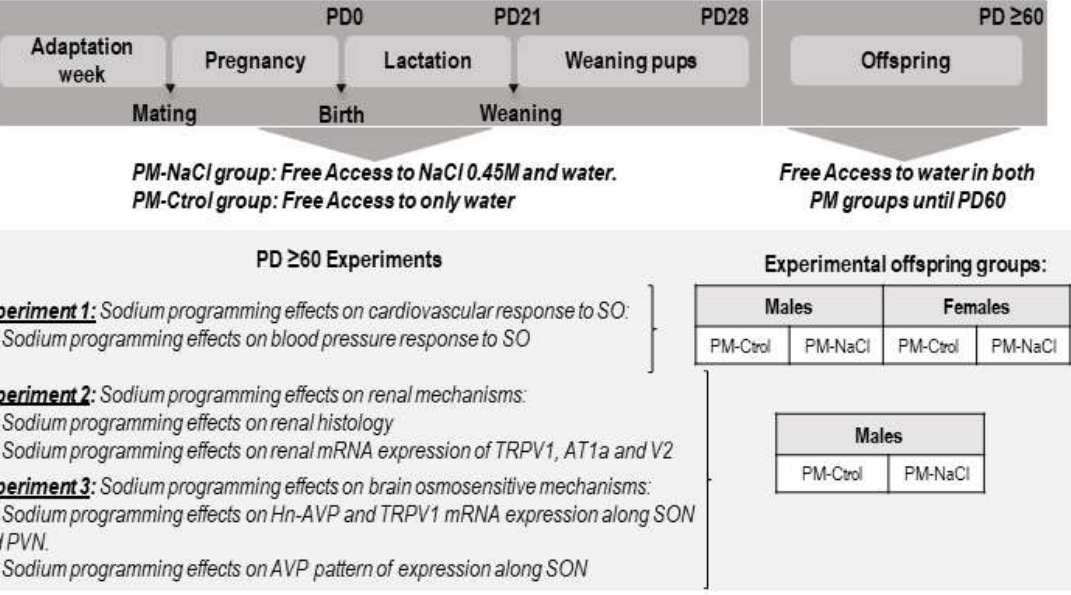
Figure 1. Schematic diagram showing the conditions of the dams and their offspring from adaptation week until the beginning of the studies. Note that from PD28 until PD60, male and female off-spring of PM-NaCl and PM-Ctrol groups were kept in standard conditions. From postnatal day 60 (PD ≥ 60), the offspring were subjected to different experimental protocols. In experiment 1, we analyzed the effects of sodium programming on cardiovascular response to SO, for which purpose the adult female and male offspring were anesthetized and submitted to a cannulation procedure to analyze the changes in MAP after SO. Given that only male rats showed differences in the MAP (see results section), only males were included in the analysis in the following experiments (focused on the possible underlying kidney and brain mechanisms of this effect). For experiments 2 and 3, a group of programmed and control animals at baseline and after SO challenge were decapitated, and their kidneys (experiment 2) and brains (experiment 3) were collected for gene expression determination. Another group of PM-NaCl and PM-Ctrol animals were perfused at baseline and after SO to perform kidney histological determination (Experiment 2) and to determine AVP immunofluorescence intensity along SON (experiment